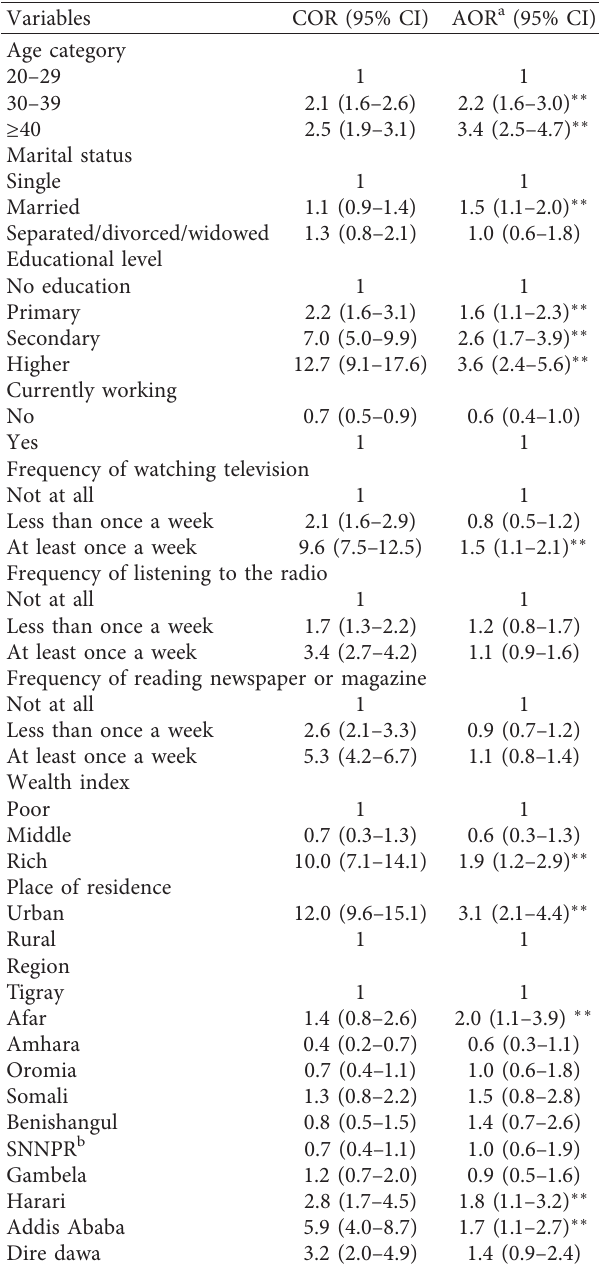
Table 2: Determinants of overweight or obesity among men aged 20–59, further analysis of EDHS, 2016.